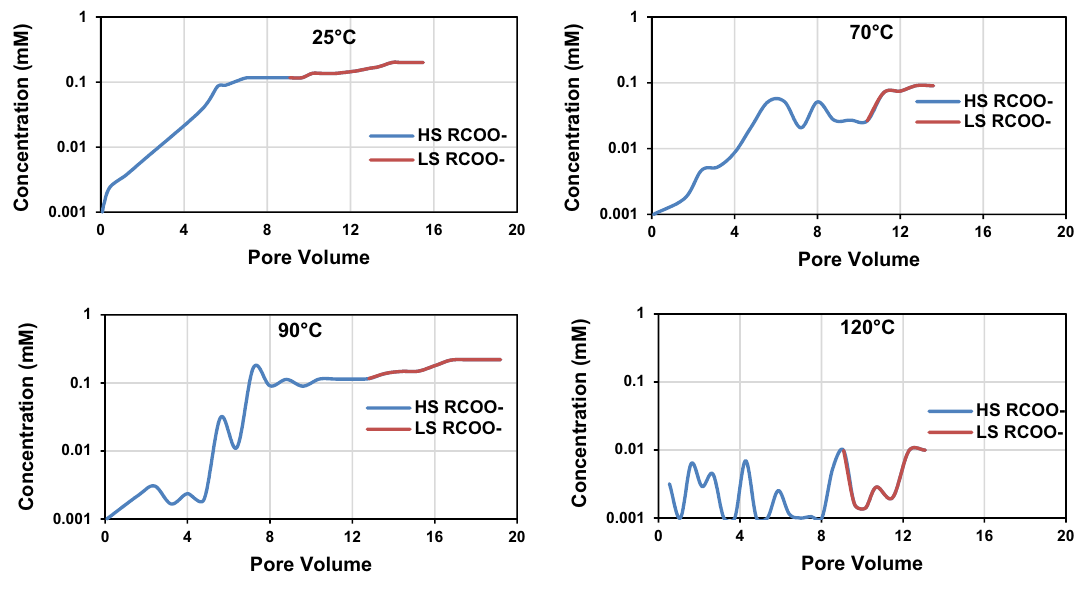
Fig. 4 Concentrations of RCOO − in first HS and LS water effluent at 25, 70, 90, and 120 column, the electrostatic attraction between the linked carboxylic on Ca 2+ [– COOCa 2+ ] and [> Si-O 2− ] became very weak and the recovery increased. A quite clear cor- relation observed for the pH gradient, as the temperature